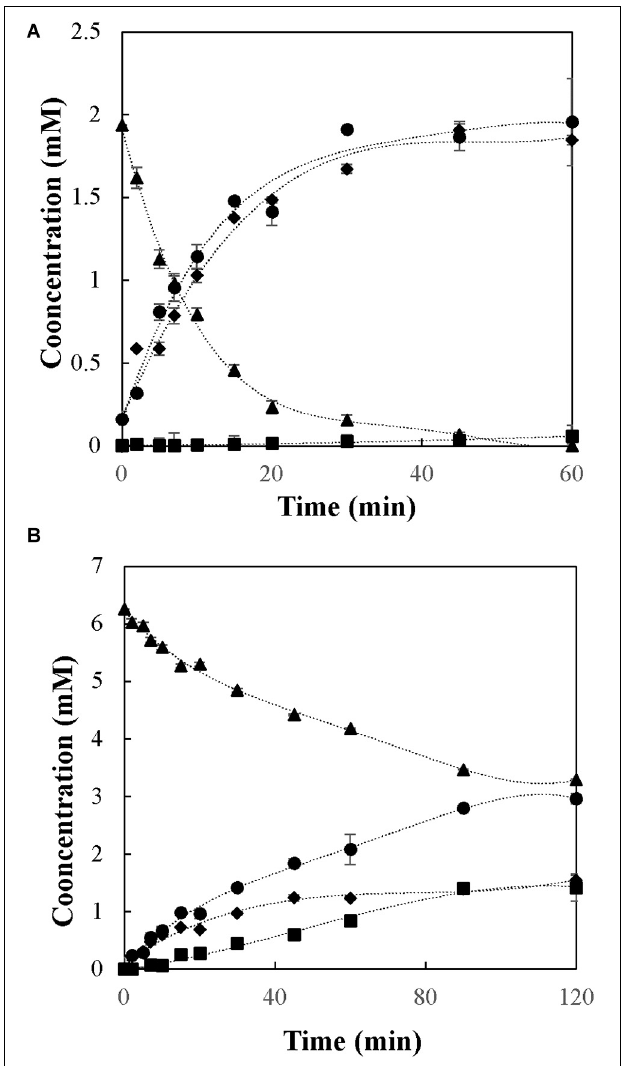
FIGURE 2 | Synthesis of butyl- β -galactoside with soluble β -galactosidase from A. oryzae in the ternary system acetone/1-butanol/aqueous solution. (A) 30/50/20 and (B) 30/10/60% (w/w) of acetone/1-butanol/aqueous solution (5 g L − 1 of lactose). Reactions were conducted at 30 ◦ C. Triangles: lactose; circles: glucose; diamonds: butyl- β -galactoside; squares: